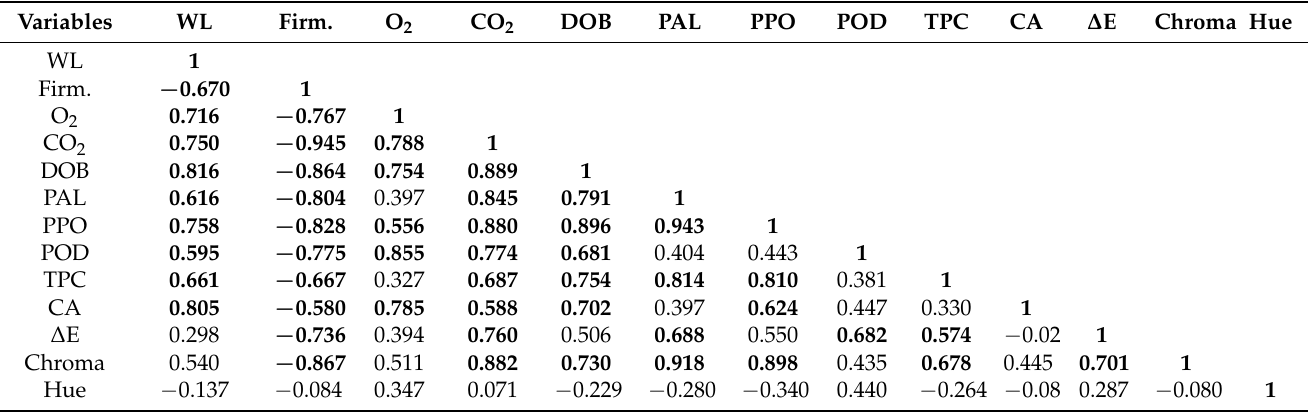
Table 3. Correlation between chemical constituents of Artocarpus odoratissimus fruit